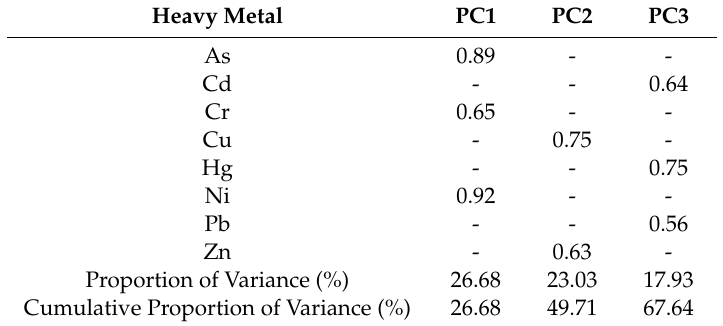
Table 4. Principal Component Analysis for heavy metals in sediments and soils from the Huixian wetland. Heavy